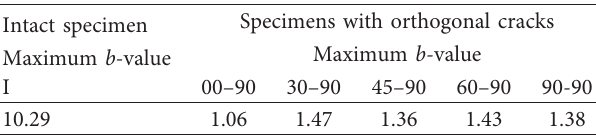
Table 1: The maximum b -value. Intact